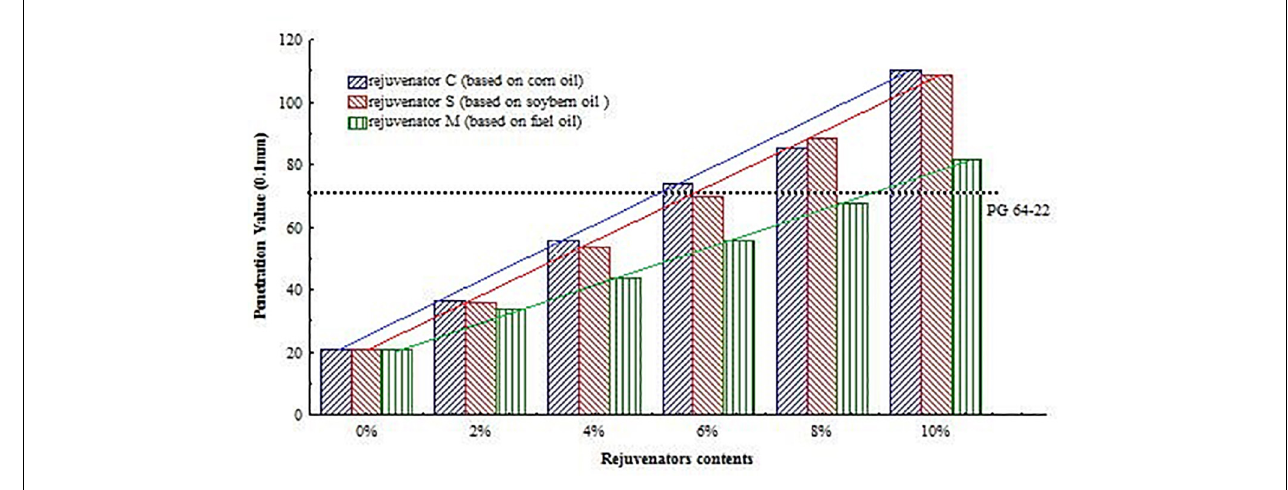
FIGURE 3 | Relationship of penetration value and different rejuvenators.